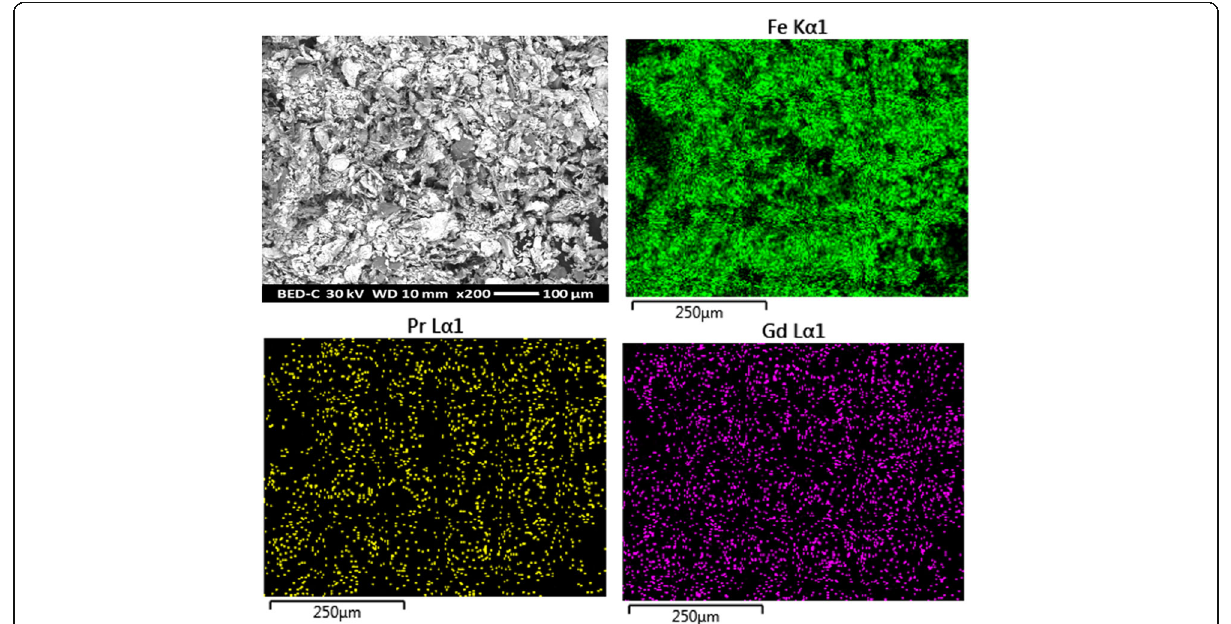
Fig. 7 Elemental mapping at the microstructural level by scanning electron microscopy with energy dispersive X-ray spectrometry of the magnetic